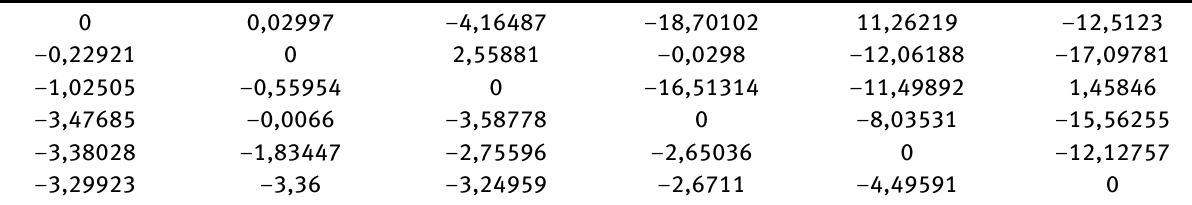
Table 1: Asymmetric weight coeflcients of neural network (case 1)